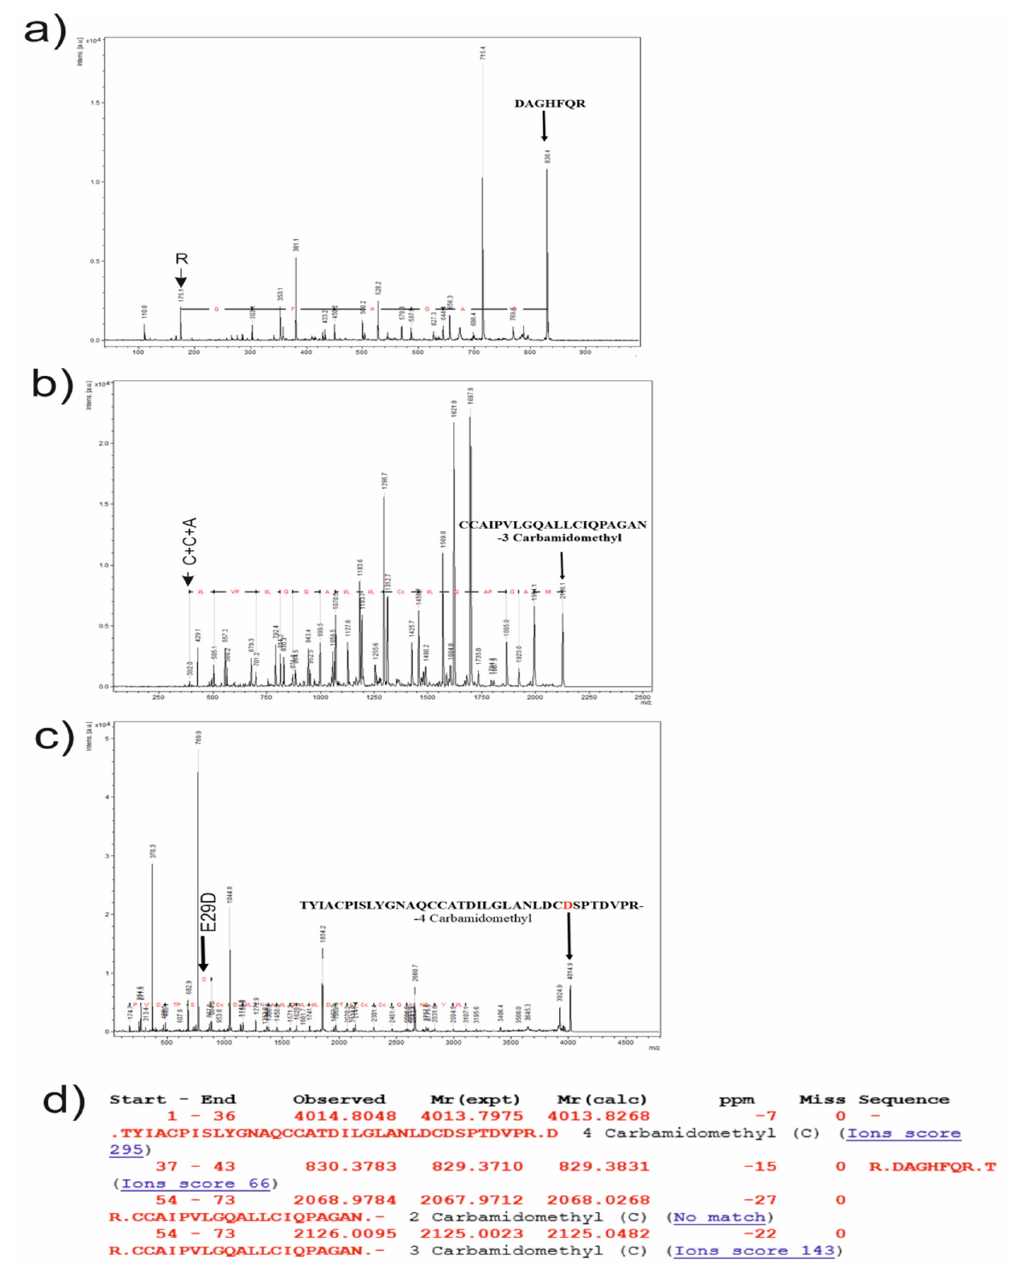
Figure 8. Sequencing of the hydrophobin. ( a – c ) MALDI-TOF MS|MS specters of different fragments of the hydrophobin, obtained with the utilization of trypsinolisys and separated with the RP-HPLC method, are presented. The characters of fragments are pointed out in black above the rightmost peak in every specter. In addition, the annotation to other peaks is exhibited with black labels above the corresponding peaks, and the amino acid change is indicated with a label and arrow. The process of sequencing is exhibited with a black line joining together the corresponding peaks with a red annotation in amino acid (acids) symbol(s). ( d ) The probable fragments of trypsinolisys with different types of modification, which were predicted with Mascot service free web software for MALDI-TOF ion prediction correlated with the masses exhibited on the specters above, are